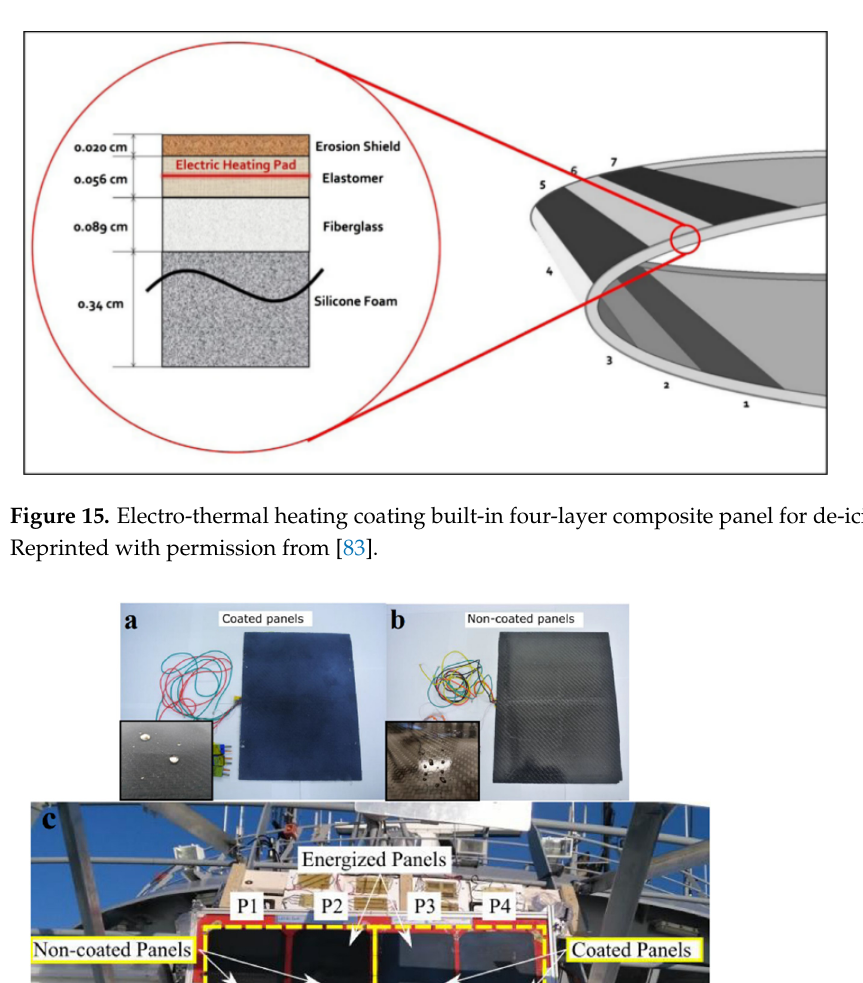
Figure 15. Electro-thermal heating coating built-in four-layer composite panel for de-icing pur- poses. Reprinted with permission from [83].